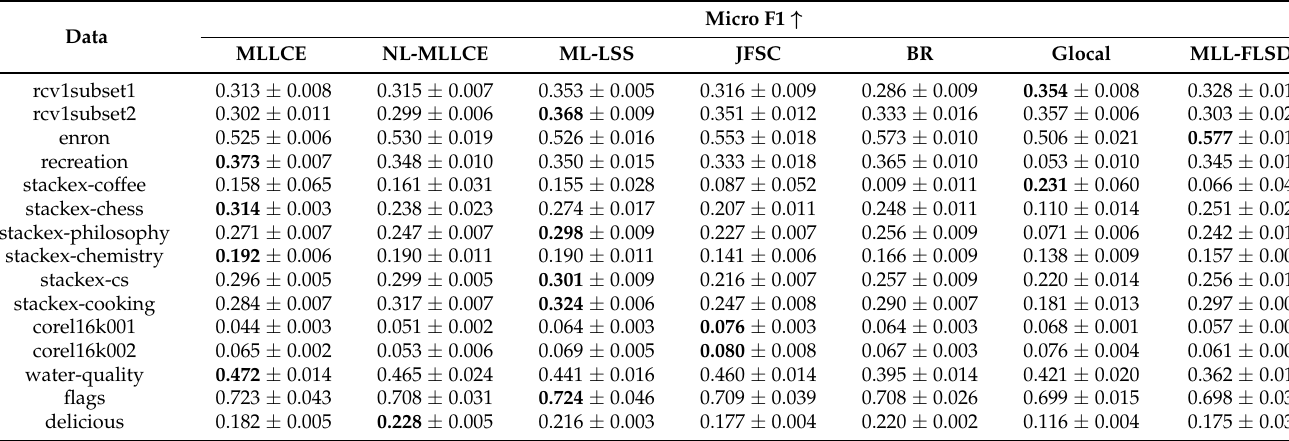
Table 7. The experimental results (mean ± standard) of all comparison methods in this paper in terms of Micro F1. ↑ means that the larger the value, the better the performance is. The best results in each row are highlighted in bold face.